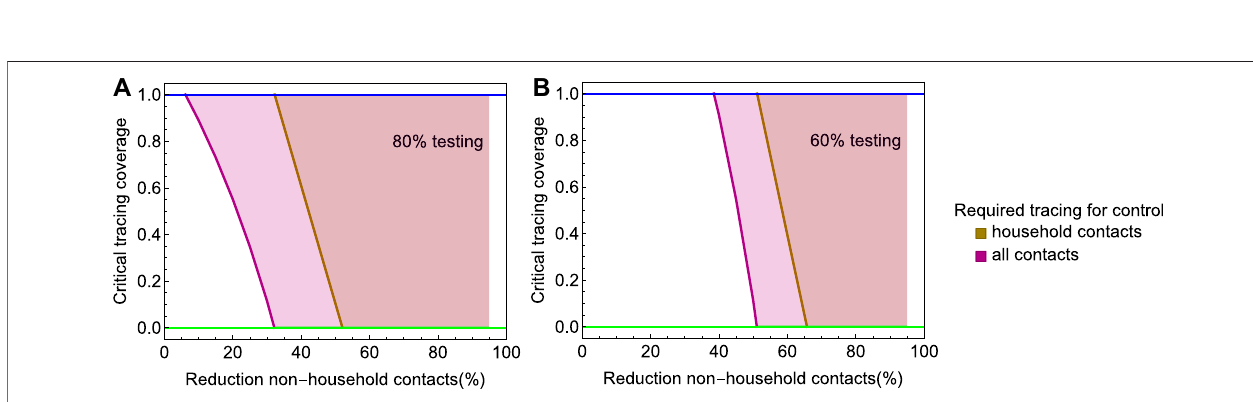
FIGURE6| Theexponentialgrowthrateandassociatedepidemicdoublingtimeasafunctionofthetestingdelay (AandC) andcoverageofcontacttracing (Band D) . The colors depict the fraction of infections that is symptomatic, and which is varied from 60% (pink) to 80% (blue). The outbreak is controlled when the exponential growth rate is smaller than zero (red horizontal line). If 60% of infections are symptomatic, contact tracing and isolation can slow down the epidemic to around 15 days, but they cannot control it, even if there is no diagnosis delay and all non-household contacts are traced.